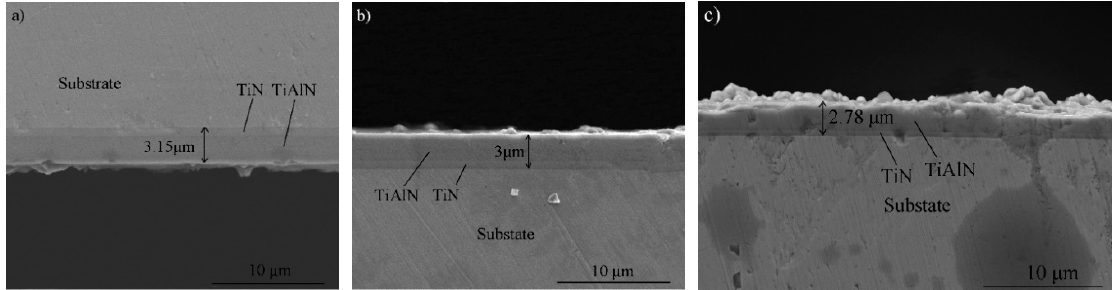
Figure 4. Cross-sectional SEM images of coating specimens: ( a ) No. 4, ( b ) No. 5, ( c ) No. 9.